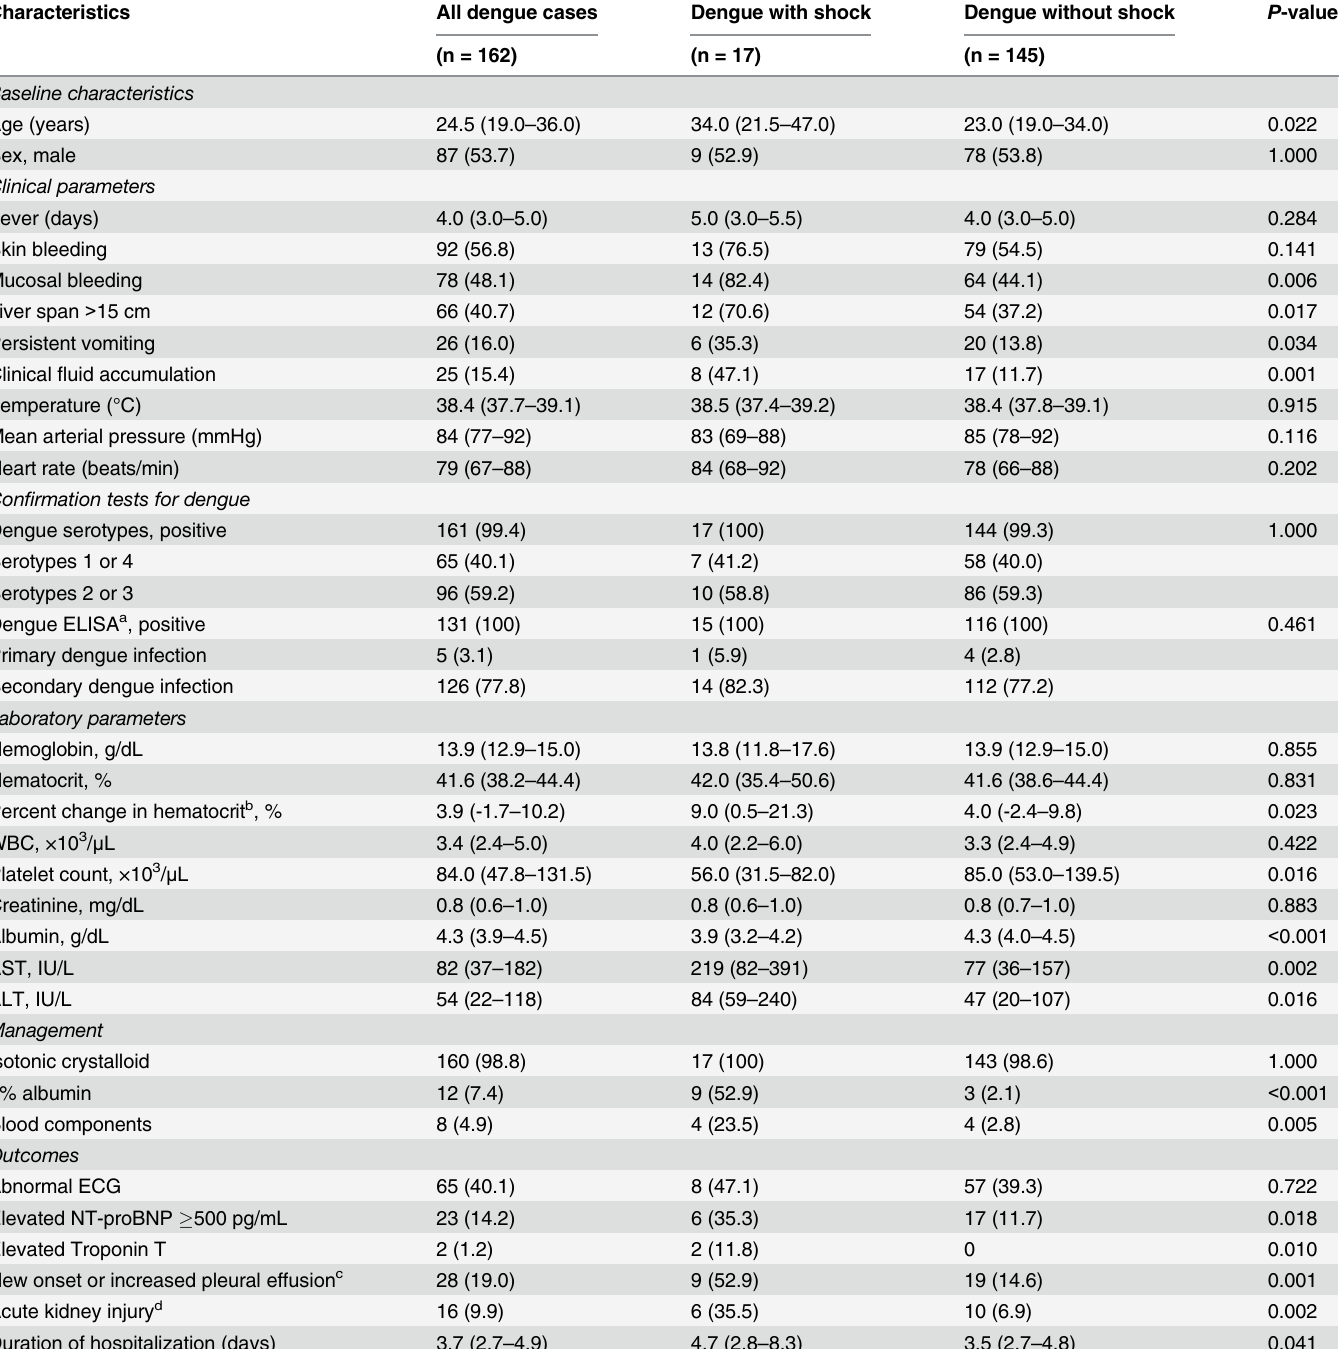
Table 1. Baseline characteristics, clinical parameters, laboratory parameters, and outcomes among 162 hospitalized adults with dengue, subdi- vided by patients with and without dengue shock.